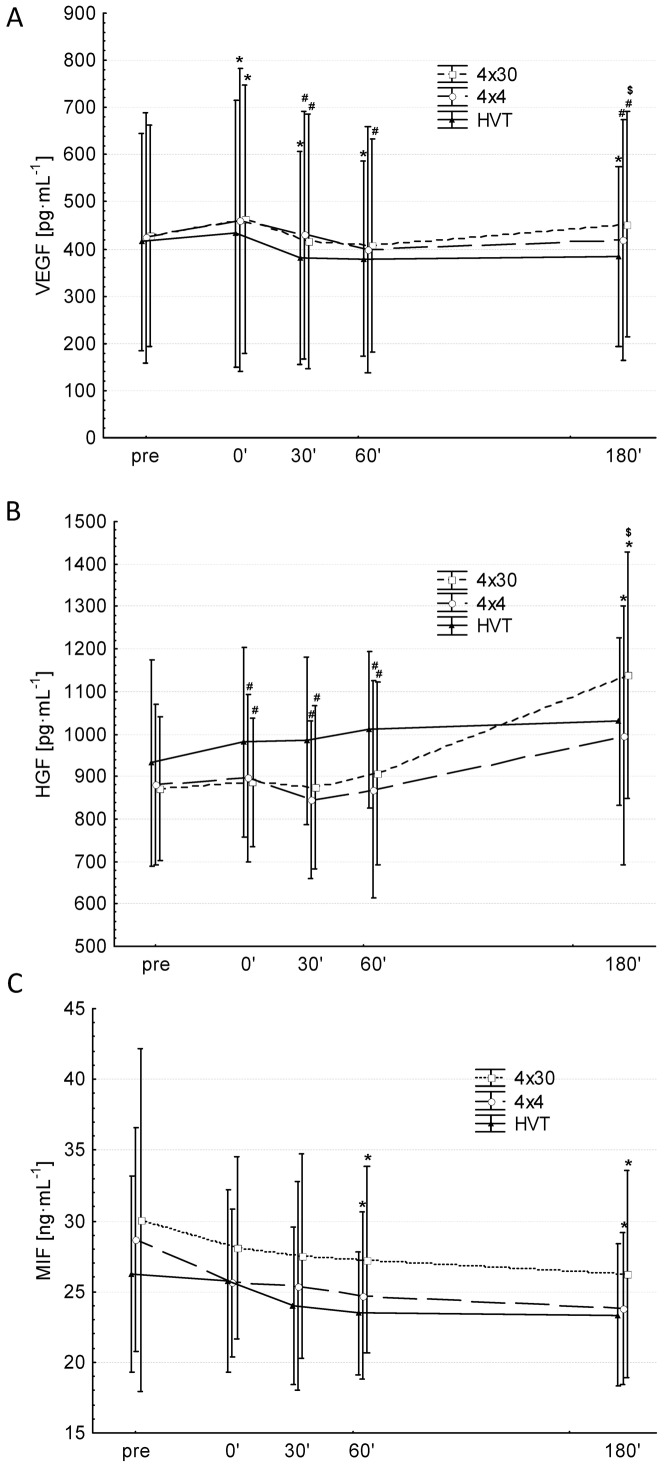
Changes in circulating VEGF (A), HGF (B) and MIF (C).4×30 sec (Squares, dotted line), 4×4 min (circles, broken line) and HVT (triangles, solid line). * significantly different compared to pre-values (p≤0.05). Values are presented as means ± SD.